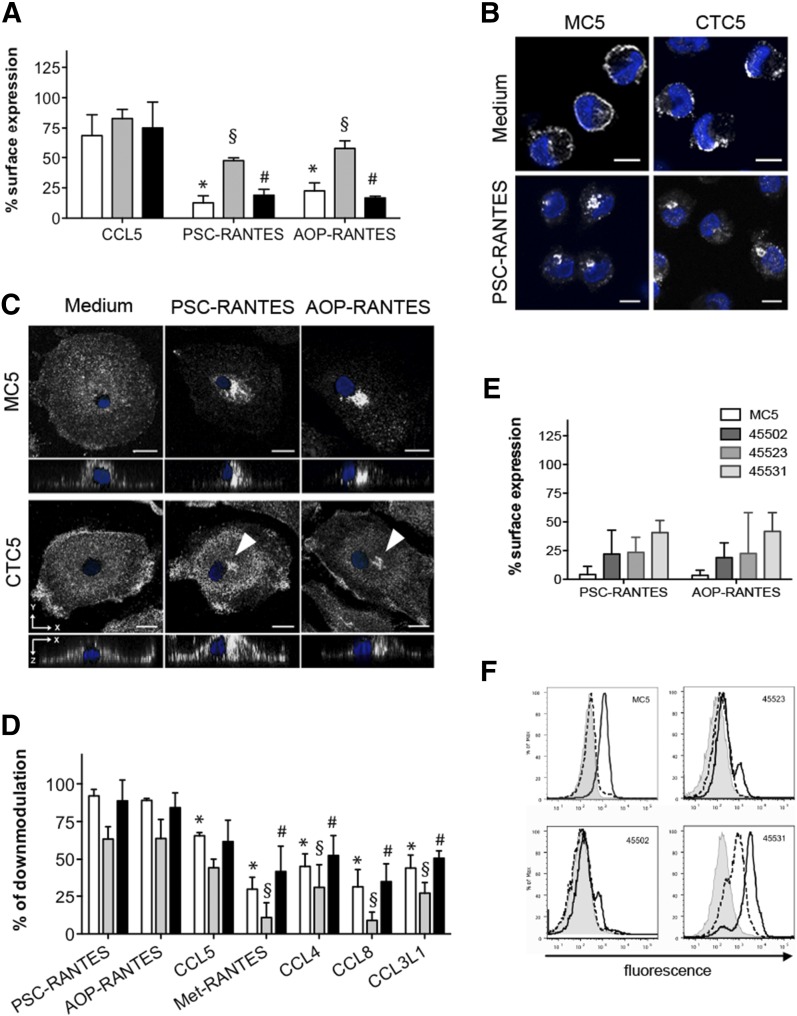
Agonist- and time-dependent effects on CTC5 epitope in myeloid cells. (A) Significant reduction of MC5 (▫), CTC5 (), and 2D7 (▪) cell surface levels following overnight treatment of monocytes with (100 nM) PSC-RANTES or AOP-RANTES compared with CCL5; P < 0.05 for MC5 (*), CTC5 (§), and 2D7 (#), with 1-way ANOVA and Tukey’s multiple comparison posttest (N = 5). (B) Monocytes left in medium or treated overnight with PSC-RANTES were fixed, permeabilized, and stained with MC5 or CTC5. Each panel shows a representative single-confocal section. Scale bar, 5 µm. (C) CCR5 distribution in MDMs after overnight treatment followed by staining of fixed and permeabilized cells with MC5 or CTC5. Panels show XY maximum-intensity projections with an XZ cross-section view reconstituted from Z stack images. Scale bar, 10 µm. Arrowheads indicate the perinuclear compartment where superagonist-treated CCR5 accumulates. (D) Down-modulation of CCR5 on MDMs exposed overnight to a 100 nM concentration of various agonists and detected by MC5 (⬛), CTC5 (), or 2D7 (▪). For each antibody, PSC-RANTES and AOP-RANTES induced significantly higher CCR5 down-modulation than other ligands. P < 0.05 for MC5 (*), CTC5 (§), and 2D7 (#) with 1-way ANOVA and Tukey’s multiple comparison posttest (N = 4). (E–F) Detection of other cell surface CCR5 epitopes on MDMs recognized by the indicated mAbs after overnight treatment with chemokine analogs (N = 3; E). (F) Representative histogram overlays showing the intensity of staining for each of those mAbs on untreated (bold line) or overnight AOP-RANTES-treated (dotted line) MDMs and for the relevant isotype control (gray shade) All graphs represent the means ± sd from independent experiments performed in triplicate on cells from N donors.